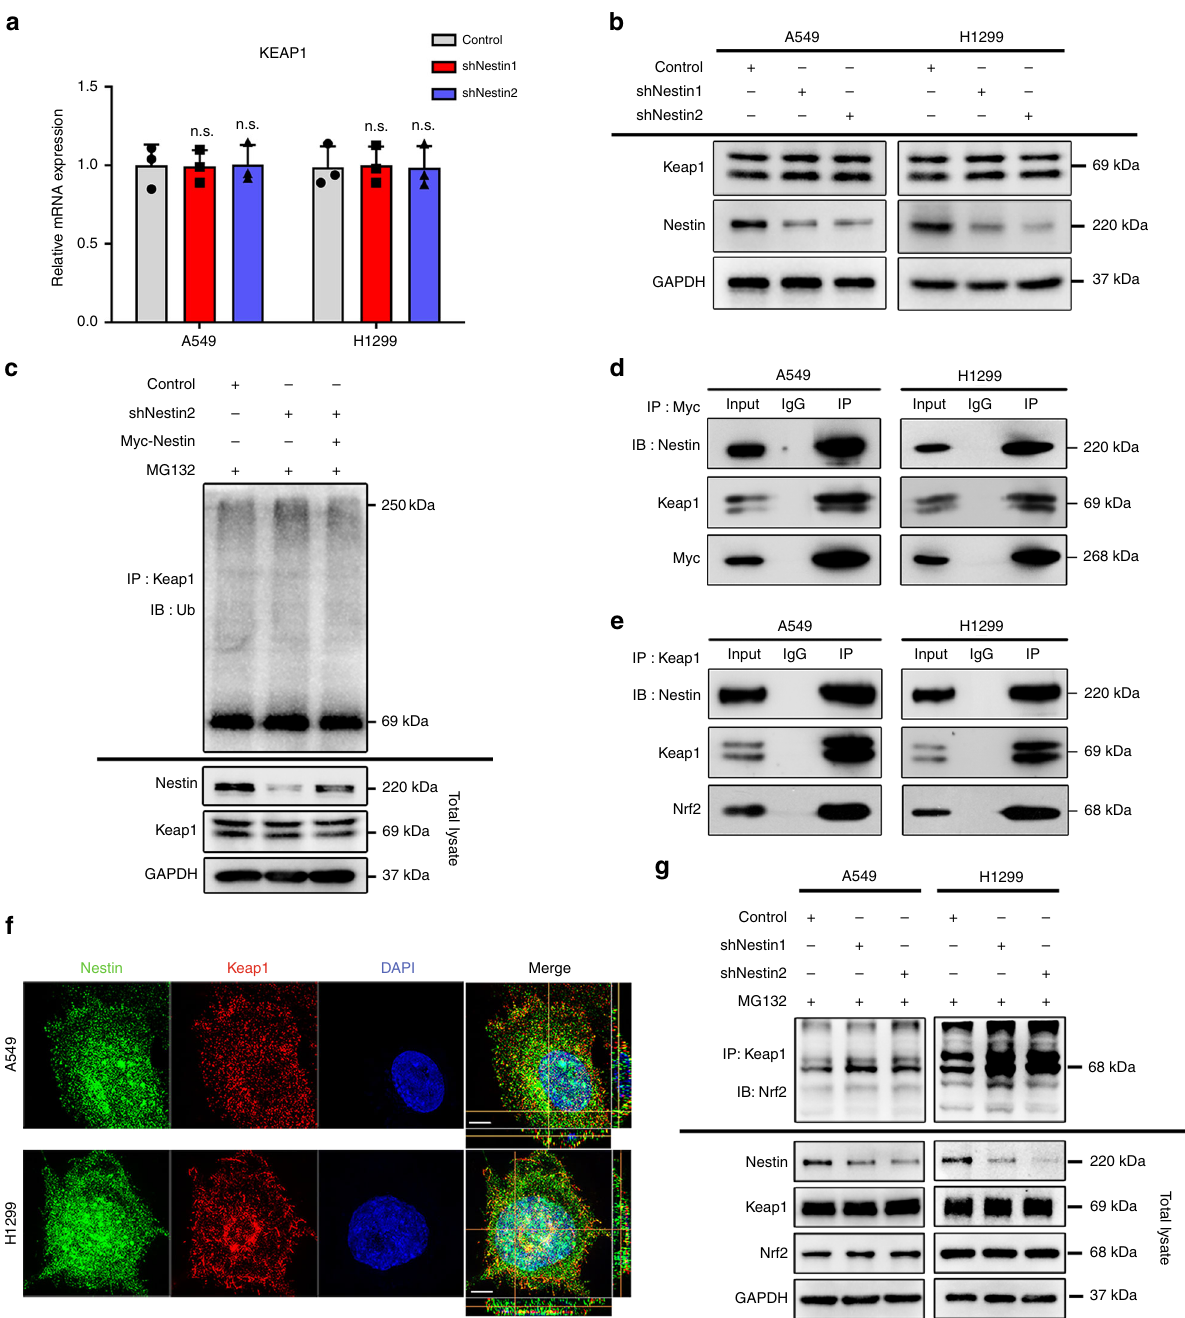
Fig. 4 Nestin interferes with the Keap1-dependent ubiquitination of Nrf2 by competitively binding to Keap1. a qPCR analysis showing that knockdown of Nestin had no effect on Keap1 expression at the mRNA level. b Immunoblotting analysis showing that Nestin had no effect on Keap1 expression at the protein level. c Alteration of the Nestin levels had no in fl uence on the ubiquitination of Keap1. Control or Nestin-knockdown cells transfected with or without a vector encoding Myc-Nestin were treated with 10 μ M MG132 for 4 h and an in vivo ubiquitination assay was performed to determine the ubiquitination levels of Keap1. d Myc-Nestin plasmids were transfected into NSCLC cells, whole-cell lysates were immunoprecipitated with anti-Myc, and the precipitated proteins were blotted with the indicated antibodies. e Whole-cell lysates were immunoprecipitated with anti-Keap1 and the precipitated proteins were blotted with anti-Nestin, anti-Keap1, and anti-Nrf2. f The localizations of endogenous Keap1 and Nestin in NSCLC cells were determined by double-label indirect immuno fl uorescence with anti-Keap1 (red) and anti-Nestin (green) antibodies. The colocalization of Keap1 and Nestin is indicated by a yellow color in the merged images. Scale bar: 5 μ m. g Nestin reduced the interaction between Nrf2 and Keap1. Control or Nestin-knockdown NSCLC cells were treated with 10 μ M MG132 for 4 h. Cell lysates were immunoprecipitated with an anti-Keap1 antibody and blotted with an anti-Nrf2 antibody. N.S. represents no signi fi cant, Student ’ s t test. Source data are available as a Source Data fi